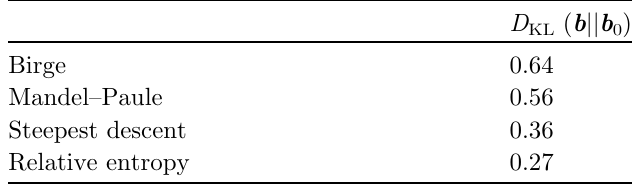
Table 2. D ( b || b ) for various adjustment schemes. Table 3. Consensus values with their associated KL 0